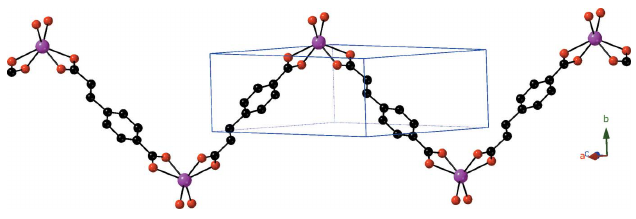
Figure 2 [Cd(cpp)(H 2 O) 2 ] n coordination polymer chain in the title compound, oriented parallel [101].